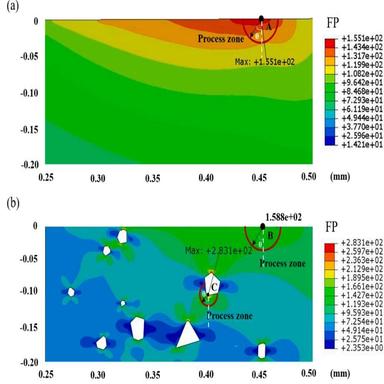
FP damage parameter contour plot for Test No. 2: (a) the homogeneous model and (b) the heterogeneous model.